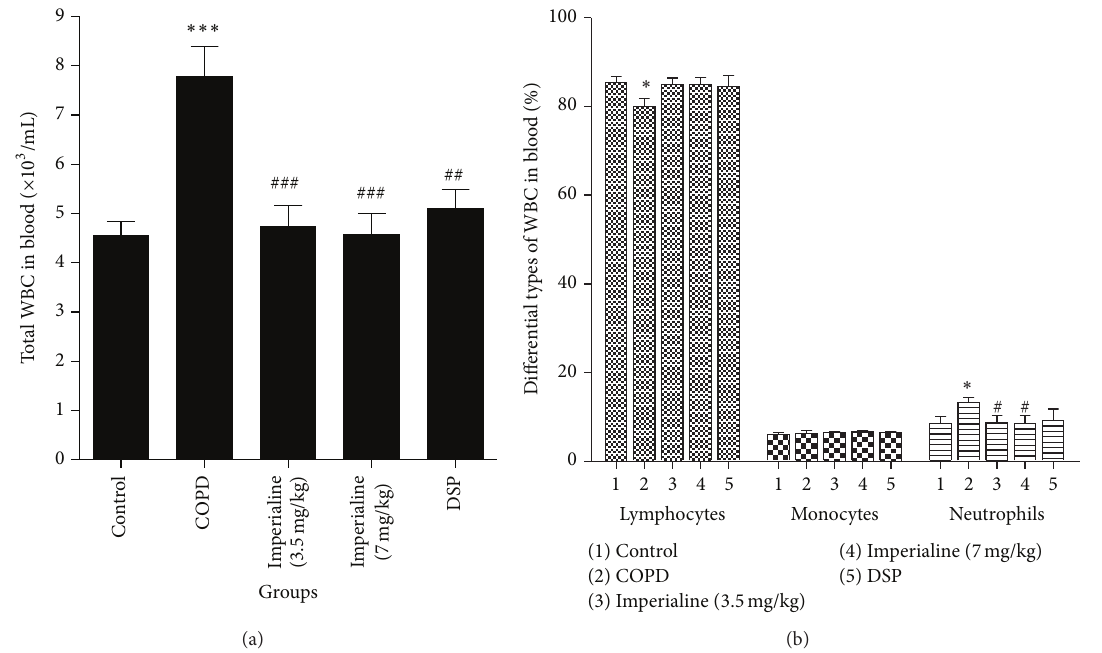
Figure 4: The effect of imperialine on the number of (a) total white blood cells (WBC) and (b) different types of WBC in the blood. Results were expressed as the mean ± SEM ( 𝑛 = 10 ). Significant differences compared with the control group were designated as ∗ 𝑃 < 0.05 and ∗∗∗ 𝑃 < 0.001 . Significant differences compared with the COPD group were designated as # 𝑃 < 0.05 , ## 𝑃 < 0.01 , and ### 𝑃 < 0.001